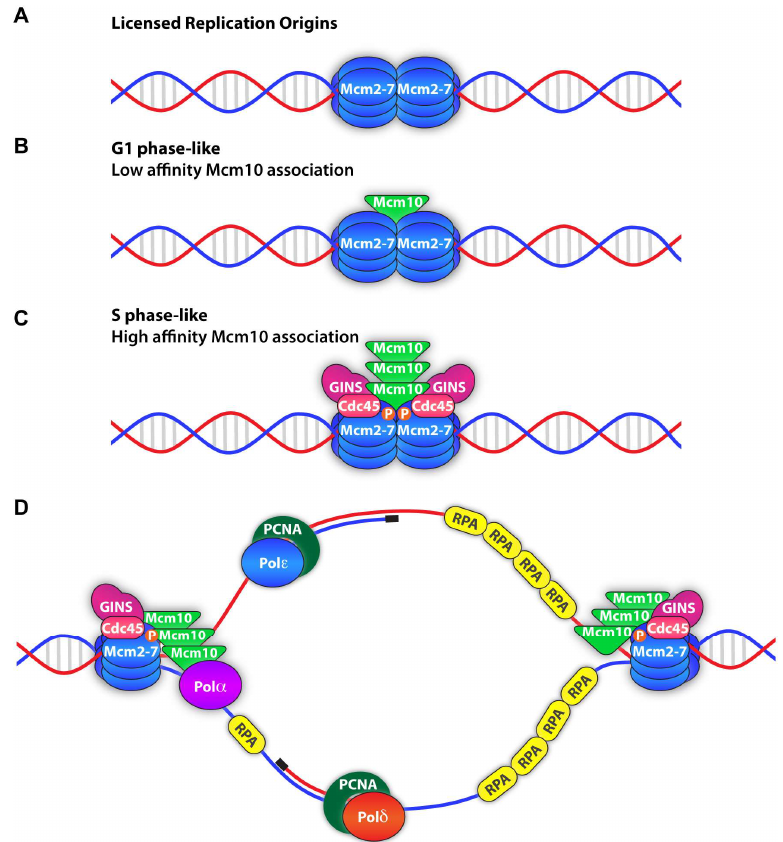
Figure 5. Model of the association of Mcm10 with the replisome in initiation and elongation. ( A ) A Mcm2-7 double hexamer is loaded onto dsDNA and represent a licensed replication origin. ( B ) Mcm10 directly interacts with the Mcm2-7 with low affinity in G1-phase-like binding prior to CMG assembly. ( C ) High affinity binding of Mcm10 to the Mcm2-7 complex in S-phase like binding takes place with formation of the CMG complex. ( D ) Following helicase activation, replication forks progress in opposite directions from each origin. Mcm10 binds and stabilizes ssDNA (right fork) and is later replaced by RPA. Mcm10 loading of DNA polymerase-alpha (Pol- α ) (left fork) is repeatedly needed